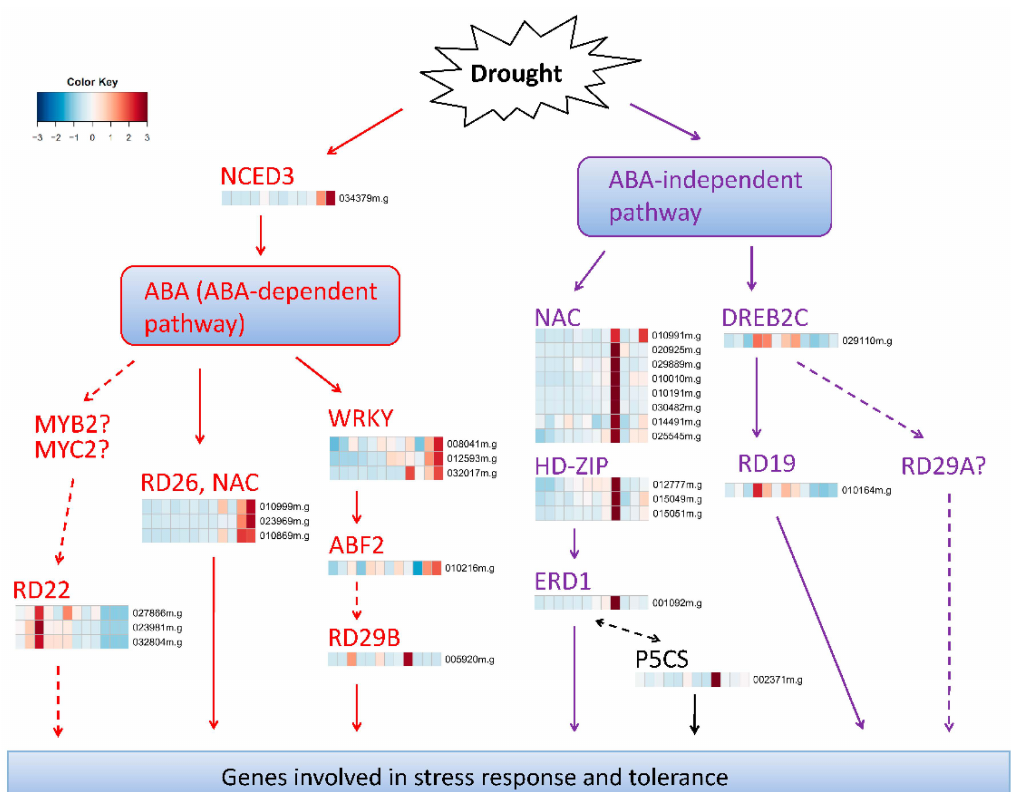
Figure 6. A model of transcriptional regulatory networks in response to drought stress in cassava. This figure is modified from Figure 2 in ShinozakiandYamaguchi–Shinozaki ShinozakiandYamaguchi –Shinozaki [46]. ABA-dependent and ABA-independent pathways were marked with red and purple, respectively. DE genes were mapped to the regulatory networks based on Mapman annotation and/or gene co-expression patterns. Solid lines indicate the interactions that were consistent with previous reported studies, while dash lines represent the interactions reported in other plants but not confirmed in our study. Question marks indicate the genes that were not differentially expressed and their functions need to be further validated in cassava. The samples (from left to right ) indicated by cells in heatmaps were the same as those in Figure